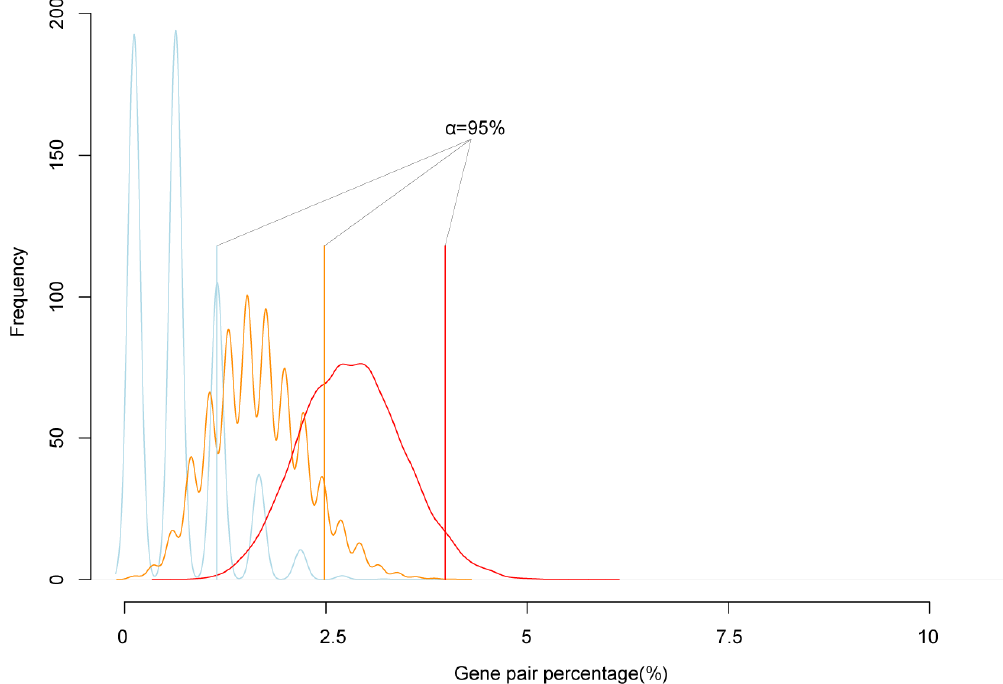
Figure 2. The simulation of the frequency of neighbor genes. The blue, orange, and red lines are the simulations of the percentage of neighbor gene accounted in randomly picked 200, 500, and 1000 genes from the genome, respectively. The solid blue, orange, red straight line is the 95% confidence interval of random neighbor genes percentage; the black straight solid line is the real neighbor genes in the detected imprinted genes.